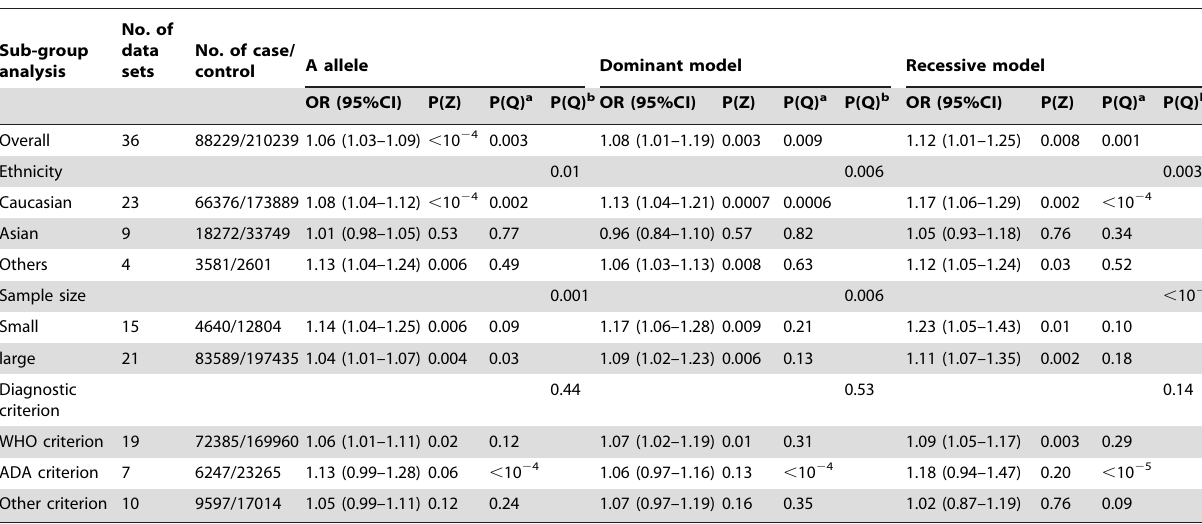
Table 2. Meta-analysis of the GCK 2 30G . A polymorphism on type 2 diabetes risk.